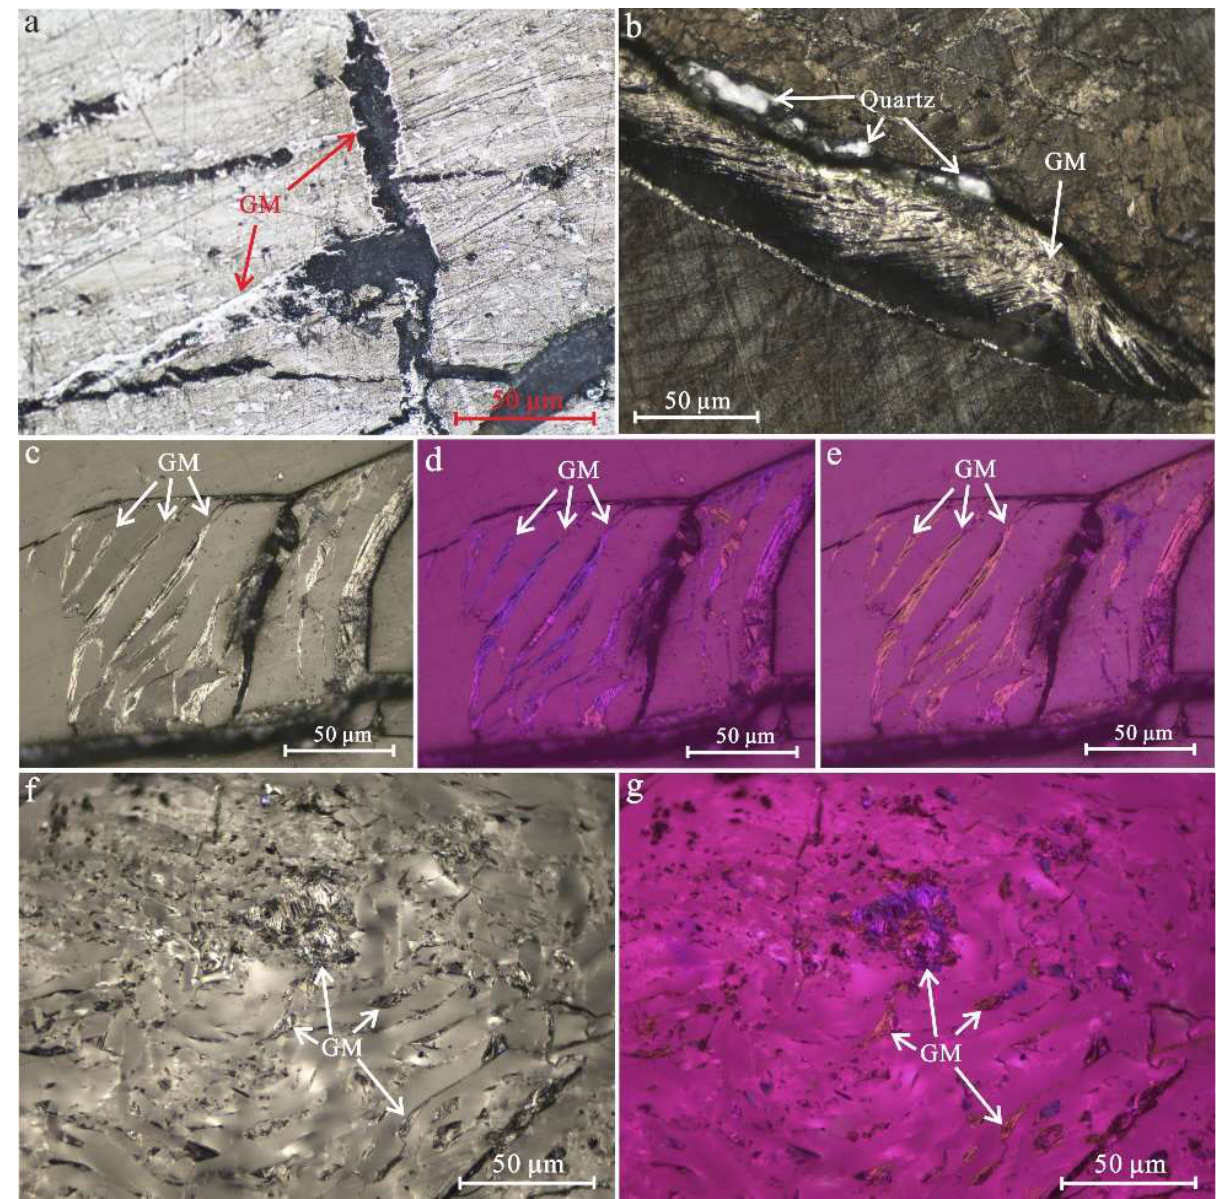
Figure 2. Occurrence characteristics of graphite microcrystals in graphitized coal samples. ( a ) Film- like graphite microcrystals as microcrack filling in sample CO1, non-polarized light; ( b ) graphite microcrystals attached fracture wall in sample JK, reflected single-polarized light; ( c – e ), graphite microcrystals as fracture-filling in PK, reflected single-polarized light for ( c ) and polarized light and with a retarder plate of 1 λ for ( d , e ), ( e ) is the same field of view as ( d ) but after stage rotation of 90 ◦ ; ( f , g ) graphite microcrystals as cell-infillings in sample QK, plane-polarized light for ( f ) and polarized light and with a retarder plate of 1 λ for ( g